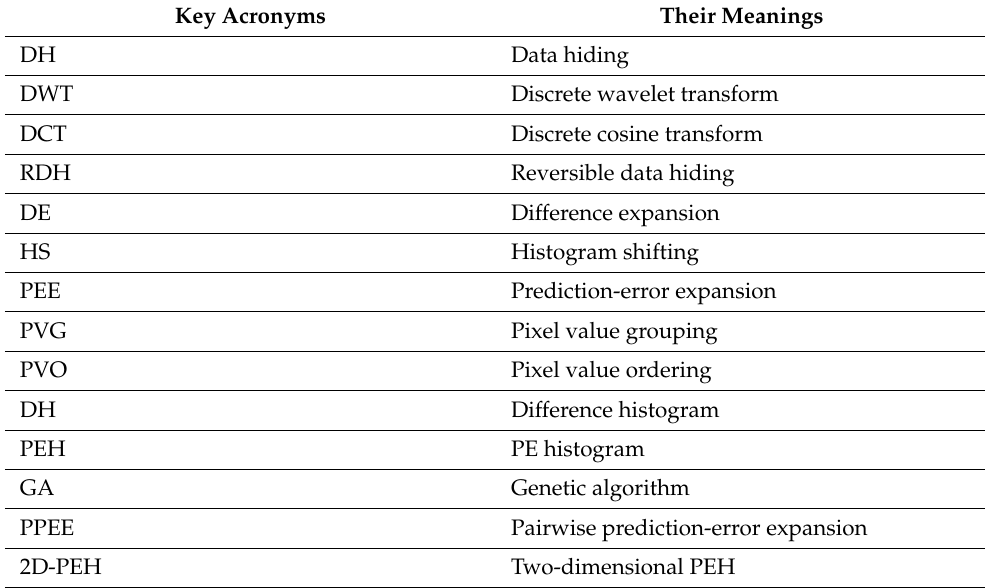
Table 1. Key acronyms and their meanings. Key